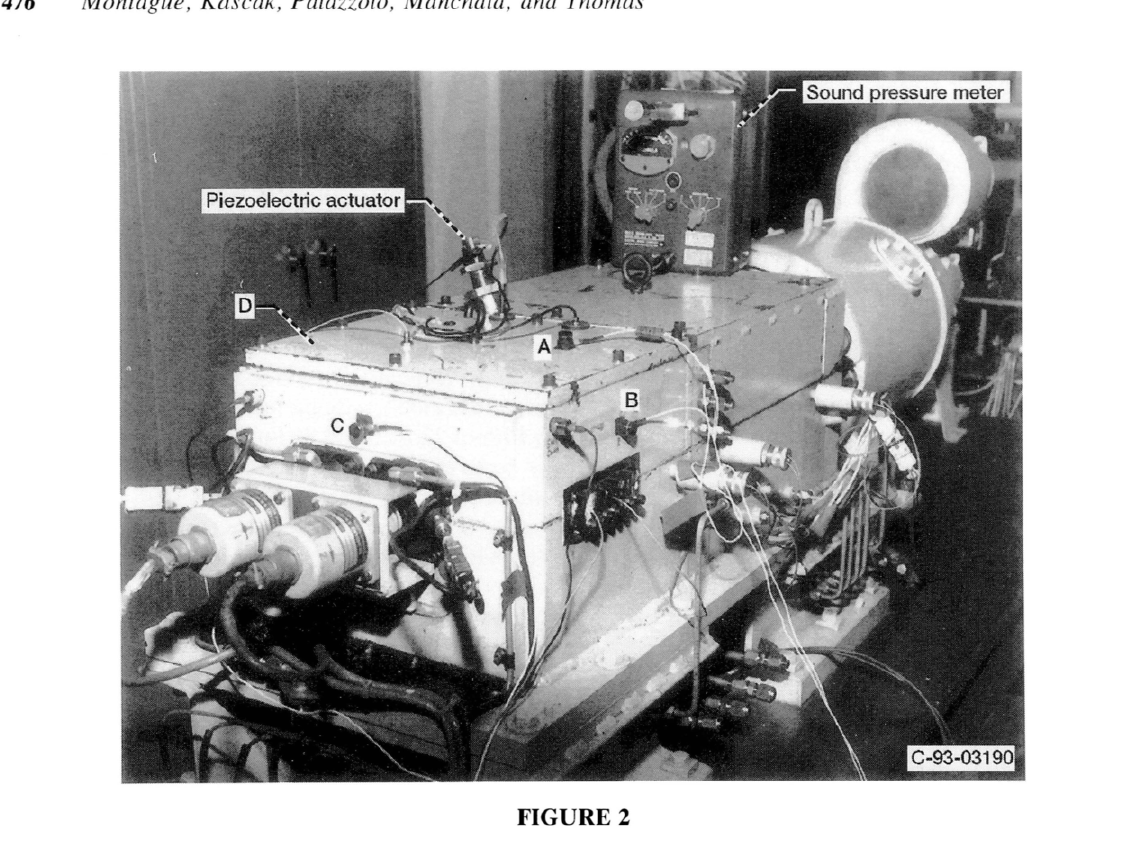
pies, 4 position encoders, and 1 sound pressure level meter.